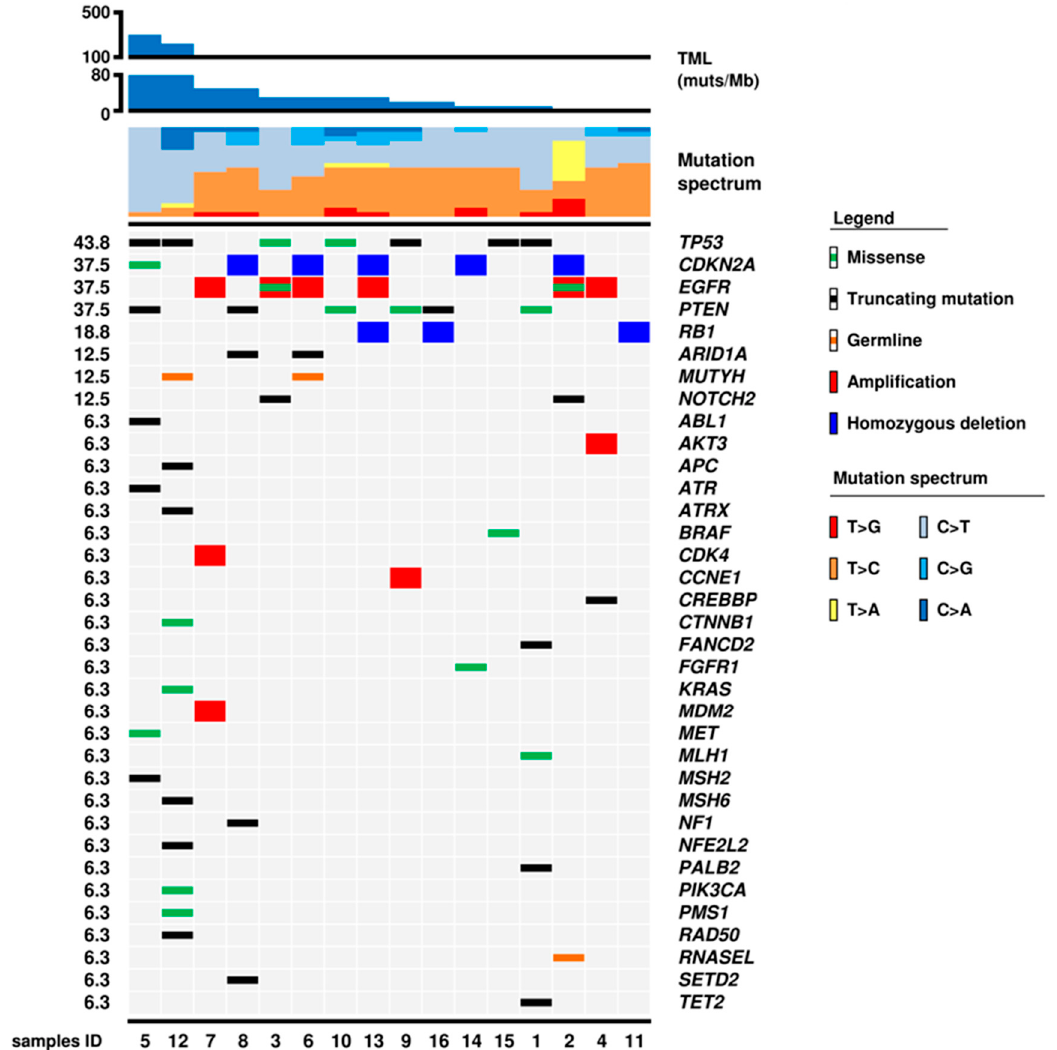
Figure 2. Genomic landscape of 16 IDH -wt glioblastomas. The matrix shows 36 genes that were altered at sequencing analysis; molecular alterations are annotated as illustrated in the panel below. Samples are ordered according to tumour mutational load (TML) from higher to lower values. The mutational spectrum is characterized by prevalent T > C and C > T transitions with low to absent contributions of T > A, T > G, C > G, and C > A transversions. The proportion of C > T over T > C increased in parallel with the increase of TML. Case 12 GL also showed a significant proportion of C > A transversions.